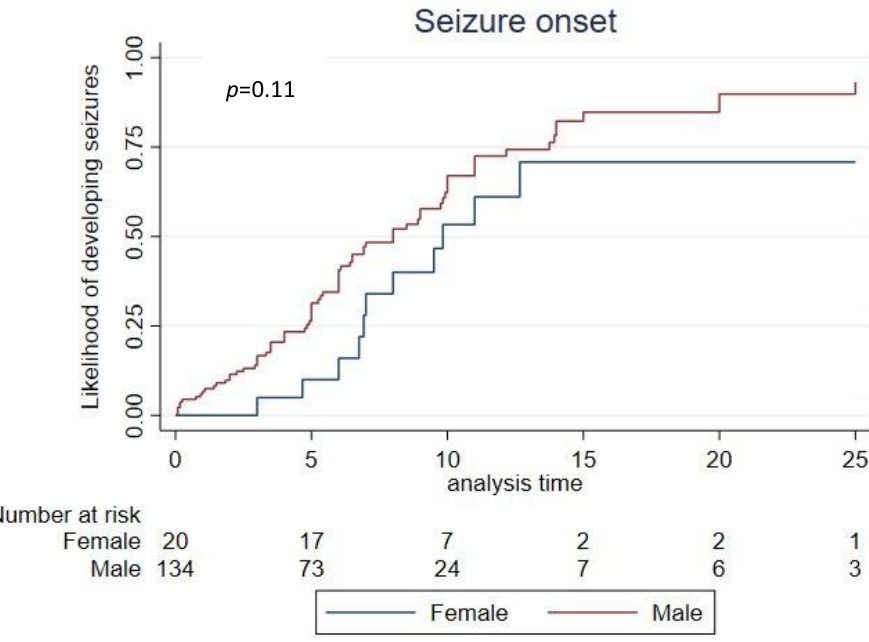
Figure 3. Time-to-event estimates of developing seizures.